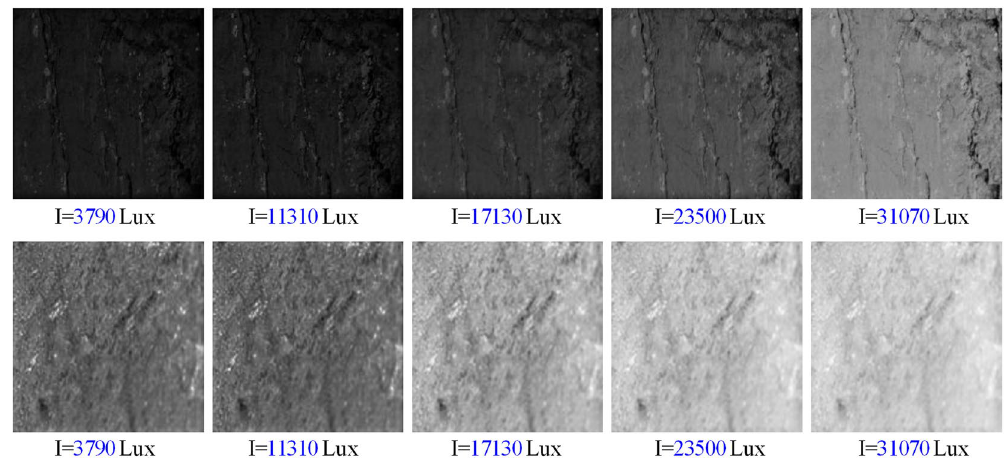
Figure 2. Grayscale sub-image of coal and